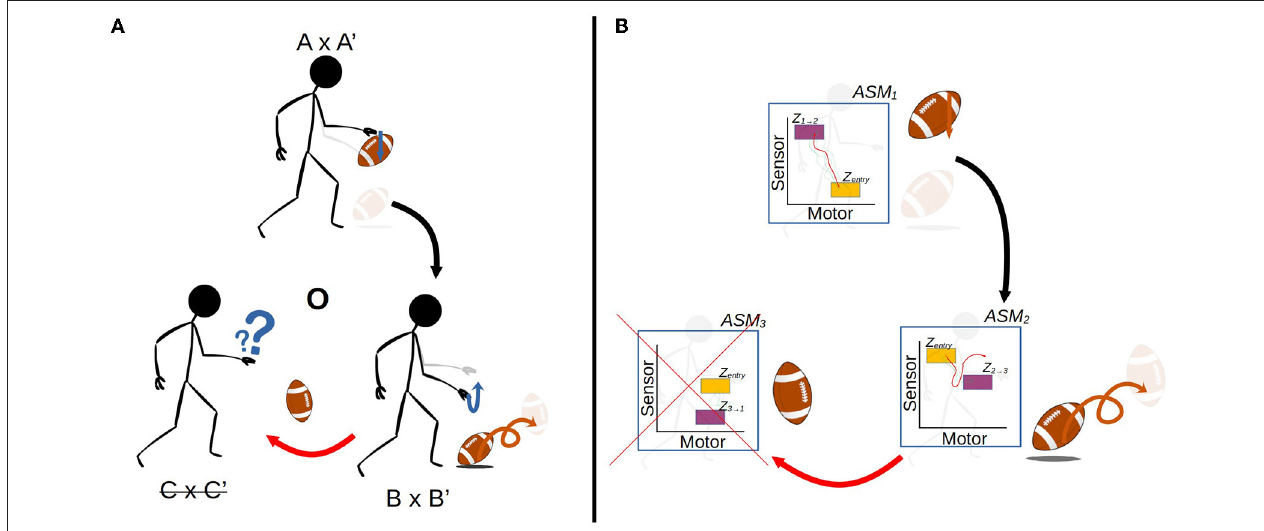
FIGURE 9 | (A) A visualization of a disruption to the basketball-bouncing scheme. The agent-side dynamics remain the same, but the environmental support for the scheme is insufficient, specifically in terms of the shape and other physical properties of the ball which cause it to bounce differently off the ground. This disruption prevents the transition from B × B’ to C × C’. (B) An idealized illustration of an ASM-network controlling a robot encountering that disruption. Although the sensorimotor regularities involved in pushing the ball downwards are compatible which the established scheme, as the ball bounces wildly the sensorimotor relationship becomes irregular, perhaps due to the variation in the robot’s visual sensors. This prevents ASM 3 from being activated as the robot is not in a suitable sensorimotor state.